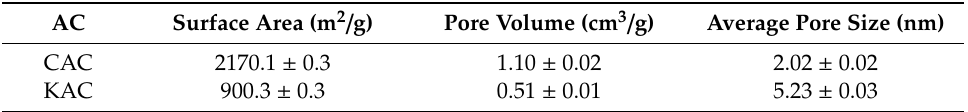
Table 2. Surface area, pore volume and average pore size of commercial activated carbon (CAC) and